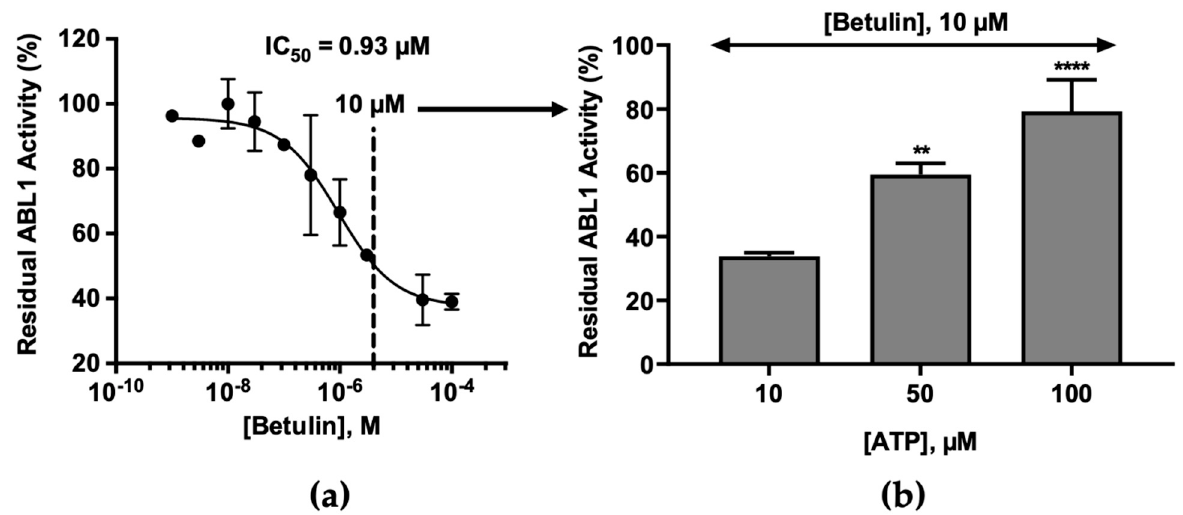
Figure 3. Effect of ATP on the inhibition of ABL1 kinase by betulin. ( a ) The IC 50 value of betulin against human ABL1 kinase was determined from the dose-response curve using GraphPad PRISM Software. ATP concentration used in the kinase assays was 10 µM (values are means, n = 2). ( b ) We selected 10 µM of betulin as fixed concentration of inhibitor (approximately 10 times the IC 50 value) and measured the inhibition by betulin at different ATP concentrations by ADP-Glo luminescent assay: 10, 50, and 100 µM. Data represent the mean (n = 4) ± SD expressed in % of residual activity, compared with a DMSO control. ** p < 0.01 vs. ATP [10 µM], **** p < 0.0001 vs. ATP [10 µM].